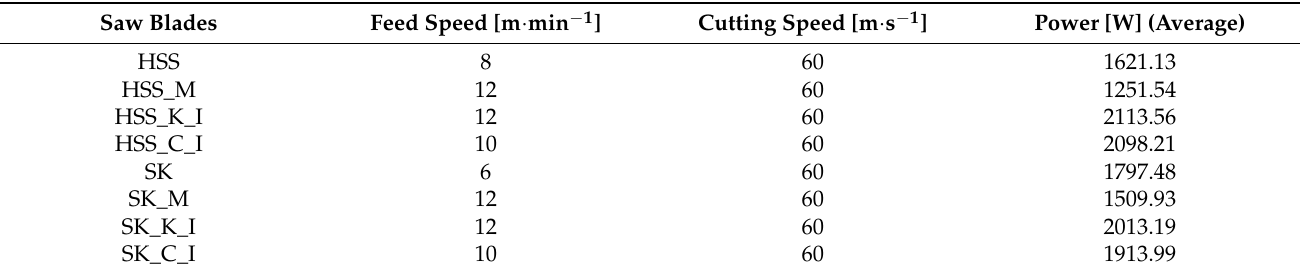
Table 5. Average performance values of saw blades (spruce